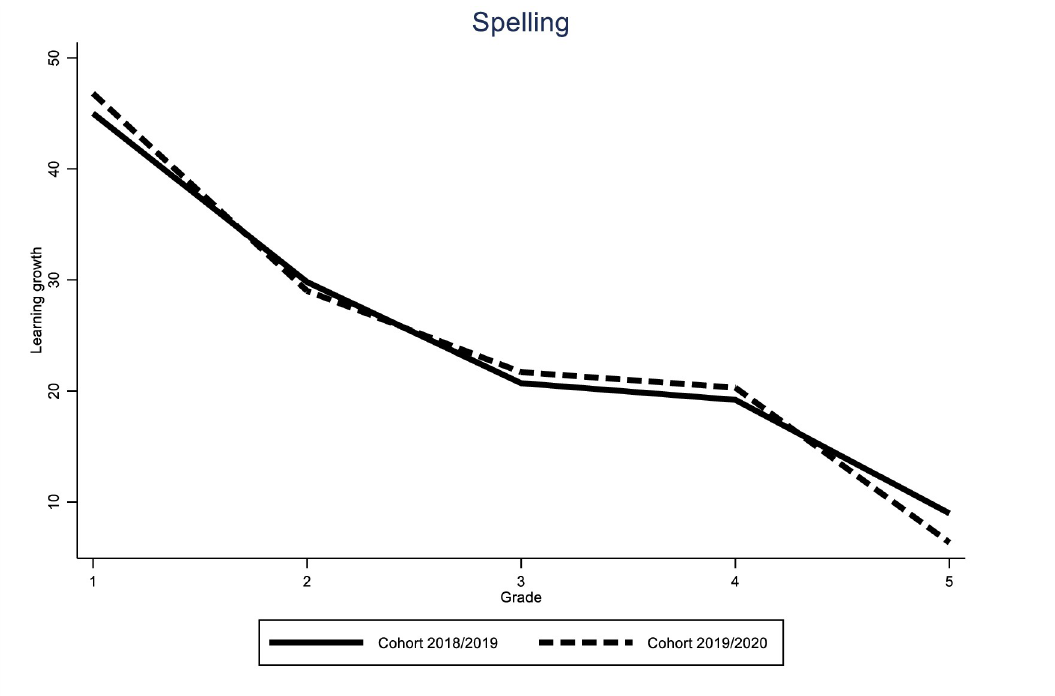
Fig 9. Learning gain: Grade 5 students of 2018/2019 compared to Grade 5 students of 2019/2020 –spelling.